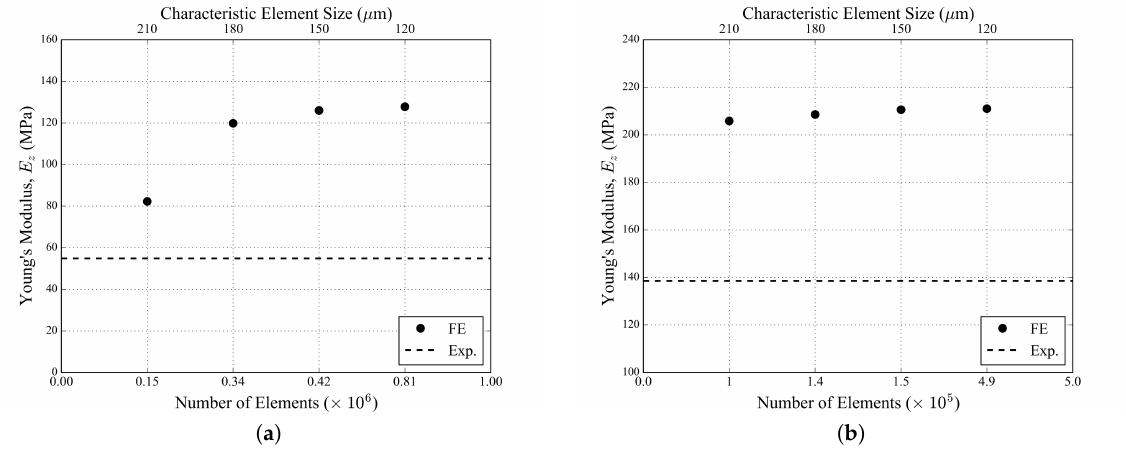
Figure 6. Apparent Young’s modulus convergence tests for ( a ) 20 PPI and ( b ) 30 PPI foam samples in the case of the homogeneous non-porous